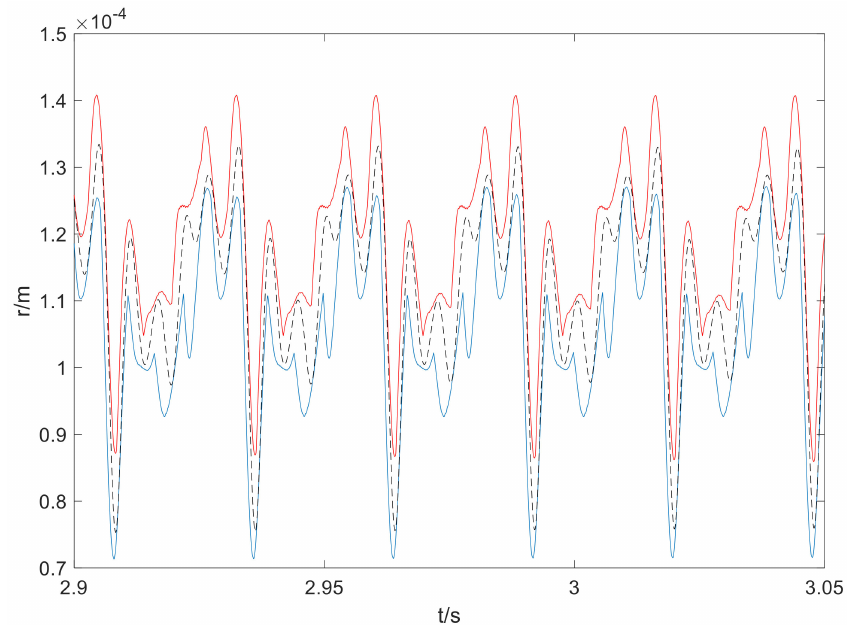
Figure 12. Vibrations of the rubbing rotor at ω = 225 rad/s with three bounded uncertainties: blue solid line = lower bound; red solid line = upper bound; black dotted line = deterministic